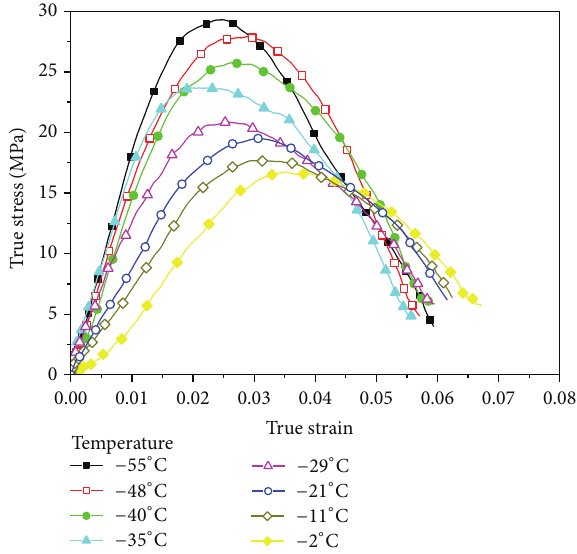
Figure 2: Stress-strain curves of the PBX at different temperatures.